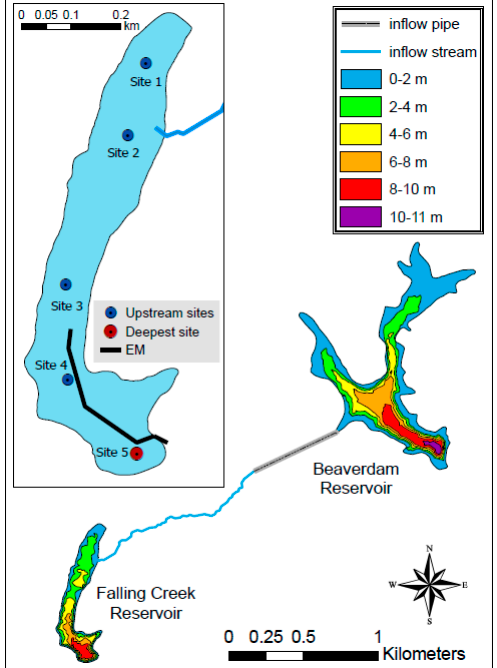
Figure 1. Bathymetric map of Falling Creek Reservoir (FCR), the focal experimental reservoir, and the reference Beaverdam Reservoir (BVR), Vinton, Virginia, USA. The inset is Falling Creek Reservoir, and EM denotes the epilimnetic mixer.